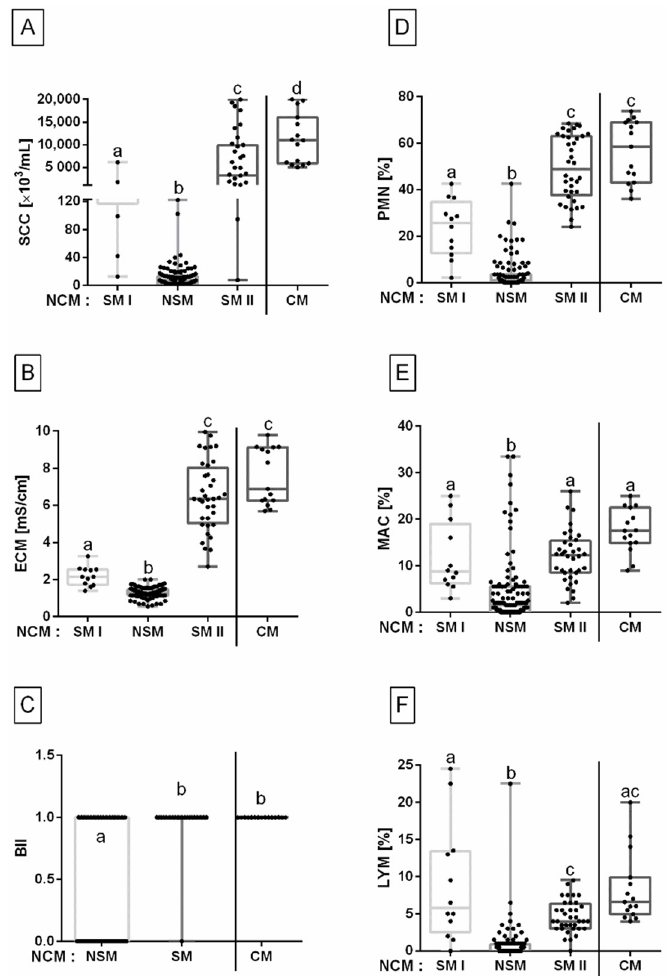
Figure 3. Somatic cell count (SCC) ( A ), electrical conductivity of milk (ECM) ( B ), Bacterial Infection Index (BII) ( C ), percentage of polymorphonuclear neutrophils (PMN) ( D ), percentage of macrophages (MAC) ( E ), and percentage of lymphocytes (LYM) ( F ) (minimum value, lower quartile, median, upper quartile, and maximum values) in the group with clinical symptoms of mastitis (CM) compared to the group with no clinical symptoms of mastitis (NCM), separated into subgroups with no subclinical symptoms of mastitis (NSM) and one ( C ) or two ( A , B , D – F ) subgroups with subclinical symptoms of mastitis (SM, SM I, SM II). The CM group was separated by a solid line. Lower case letters (a–d) indicate differences between groups for p < 0.05.